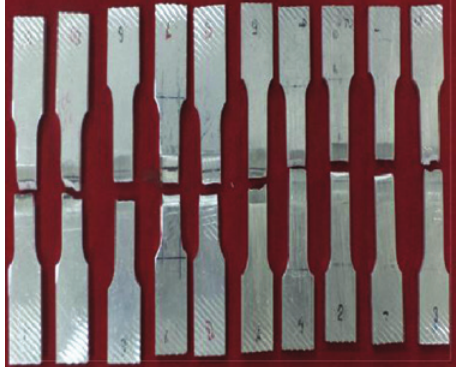
Figure 6: Photograph of fabricated FSW joint (after testing).